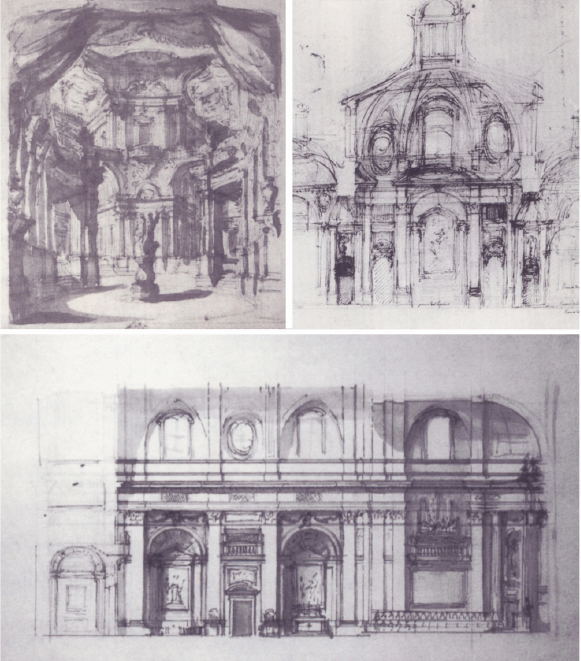
Figure 2 – Vnvitelli, L. From left above, Scene for Tito Manlio (inventory 1687), Longitudinal section of the Missions church in Naples, Longitudinal Section of the church of SS. Marcellino and Festo in Naples, Italy